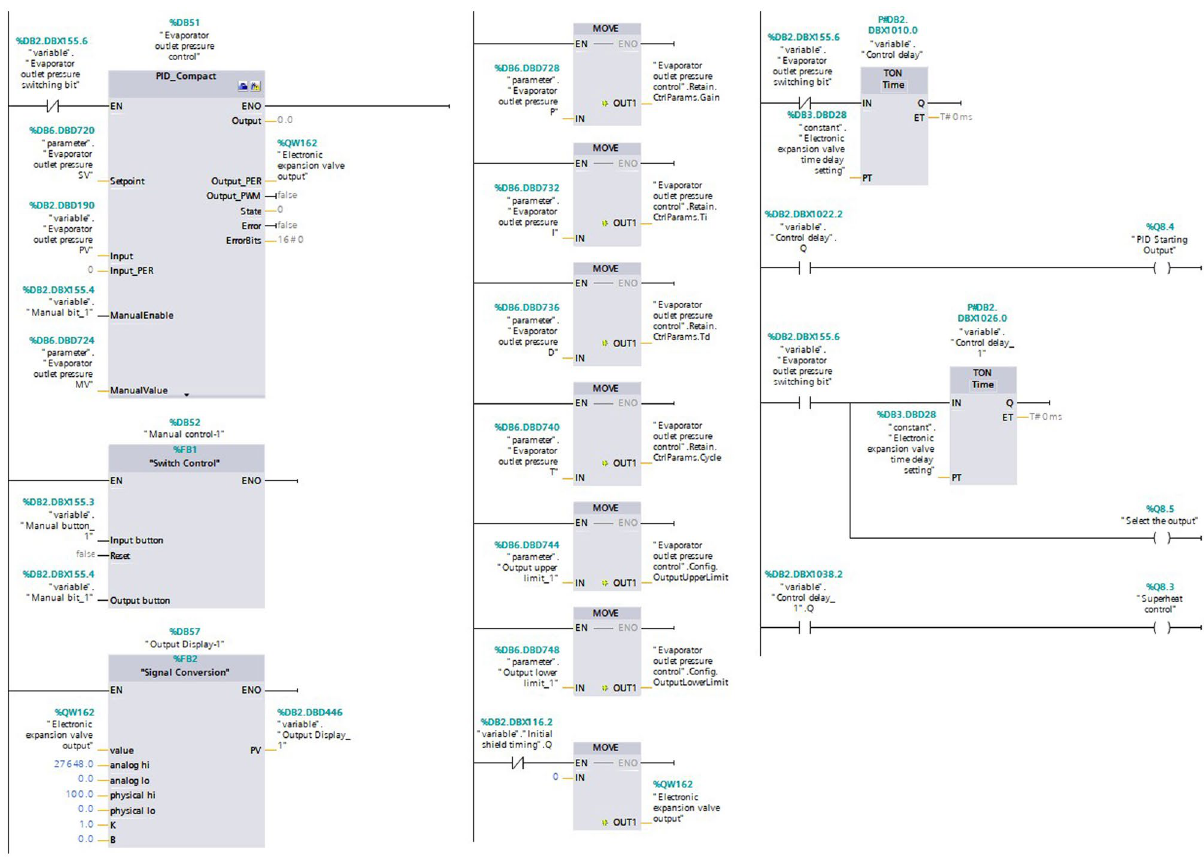
Figure 12. Main circuit EEV open degree control program.